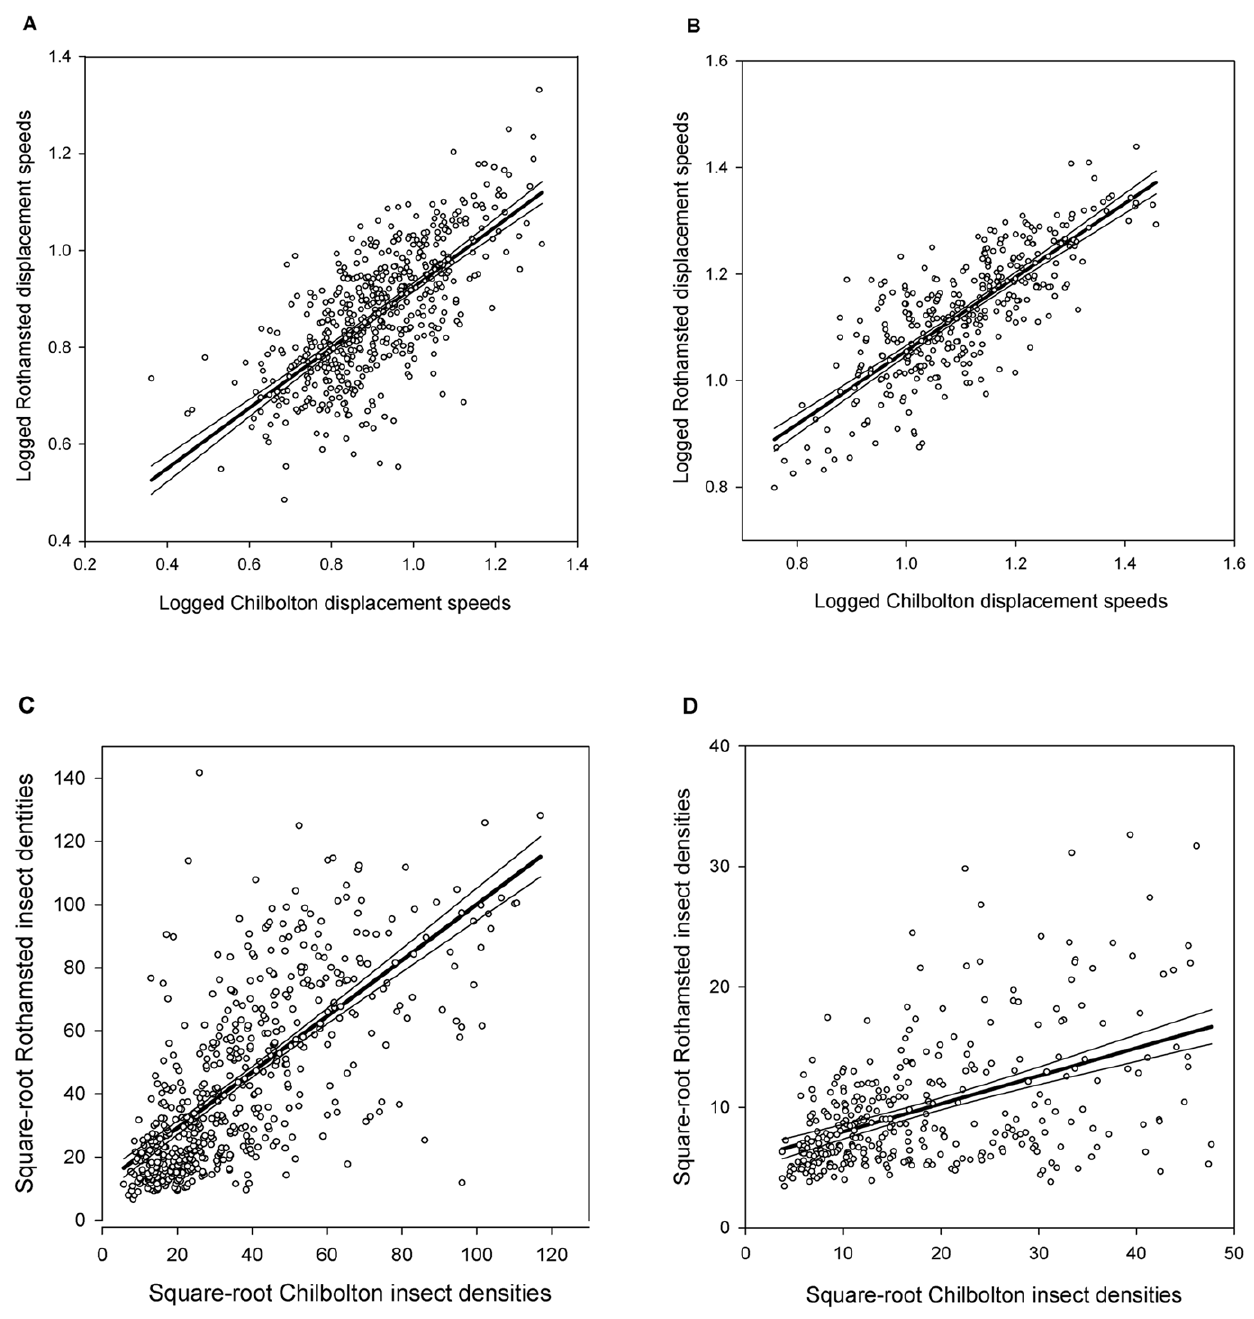
Figure 4. Linear regressions. Fitted and observed relationships with 95% confidence intervals between Chilbolton and Rothamsted logged displacement speeds by period: A. early period; B. late period, and, Chilbolton and Rothamsted square-root transformed insect densities by period: C. early period, D. late period.